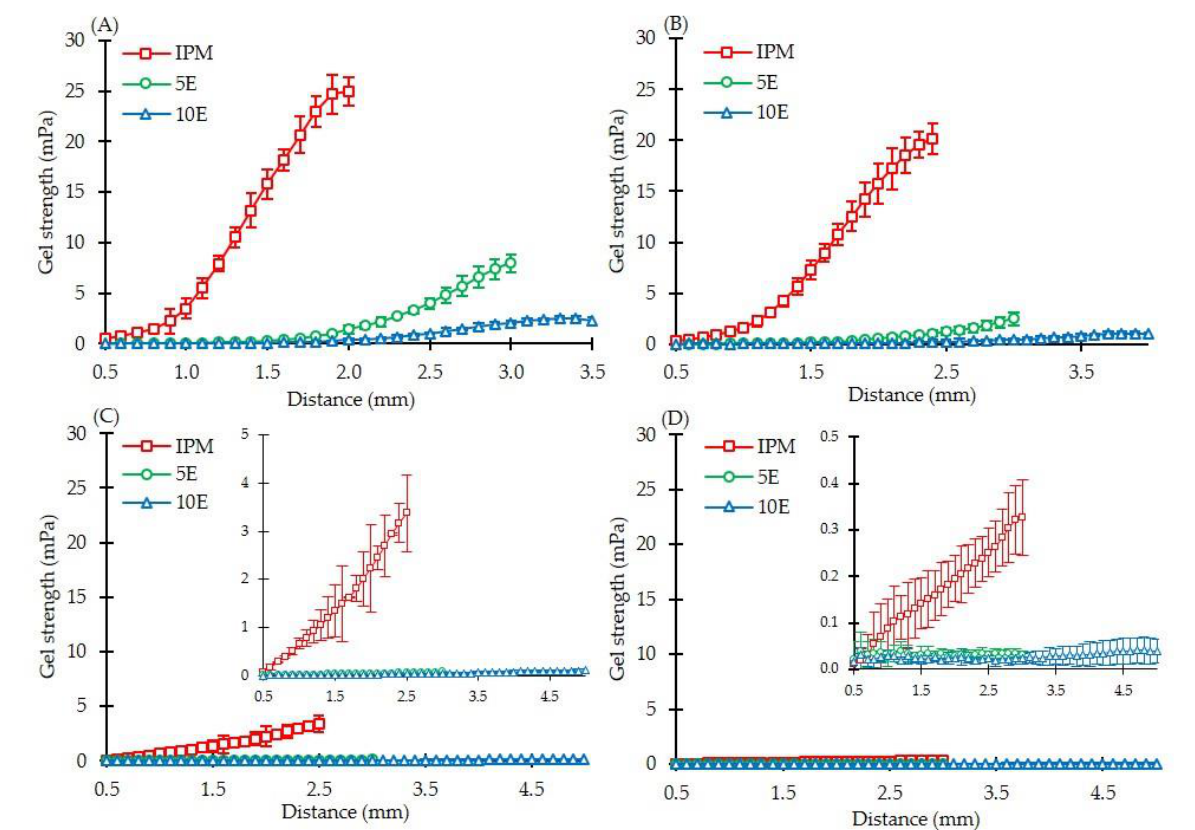
Figure 4. Gel strength profiles of IBU-P407 effervescent matrix tablets at different immersion times ( n = 5); ( A ) 15 and ( B ) 30 min; ( C ) 2 and ( D ) 4 h. Table 2. Estimated gel layer height and strength at the gel – solution interface tested in pH-changed media ( n = 5).